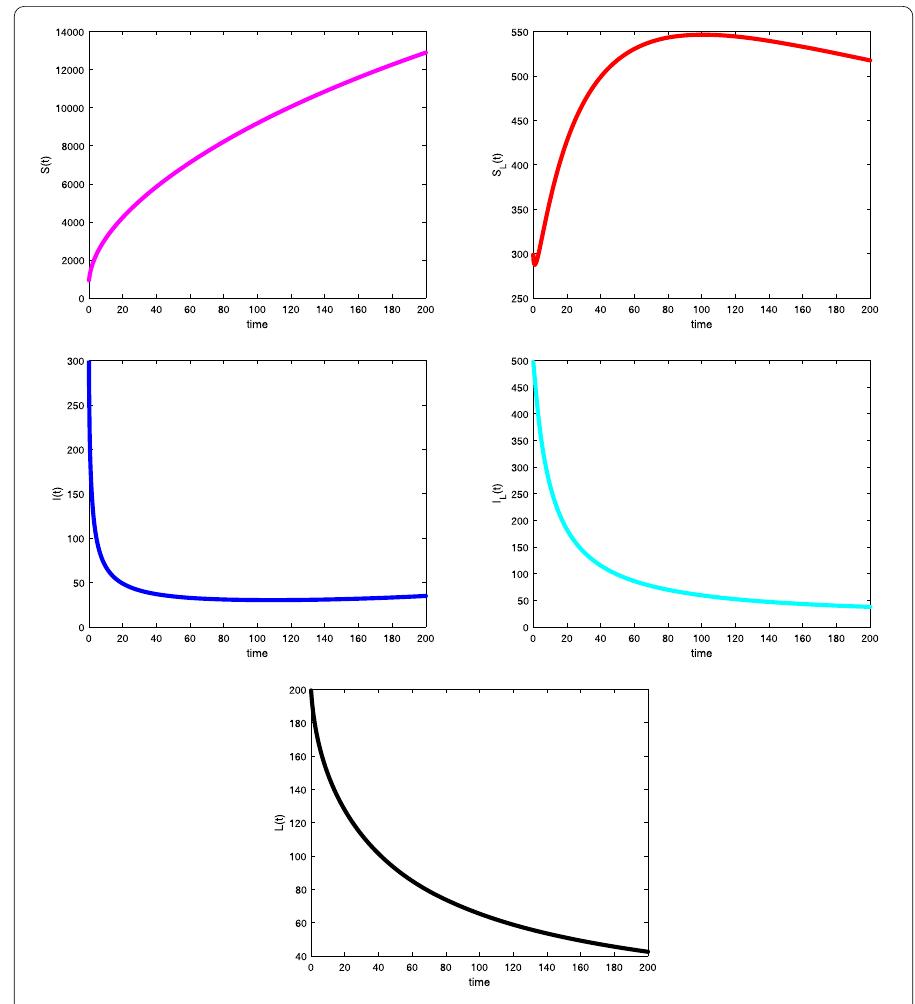
Figure 1 Profiles for behavior of each state variable for the Caputo version of the fractional model using the values of the parameters